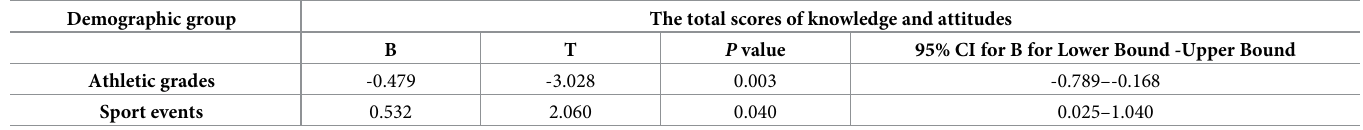
Table 4. Factors associated with participants’ knowledge and